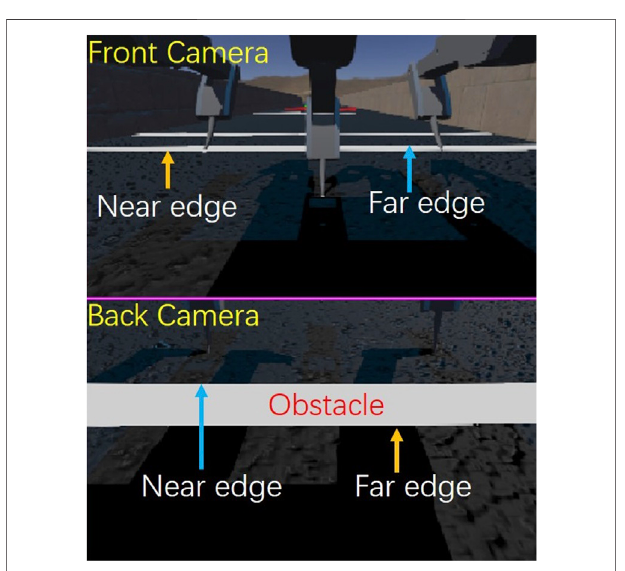
FIGURE 9 | The front and back camera views of the